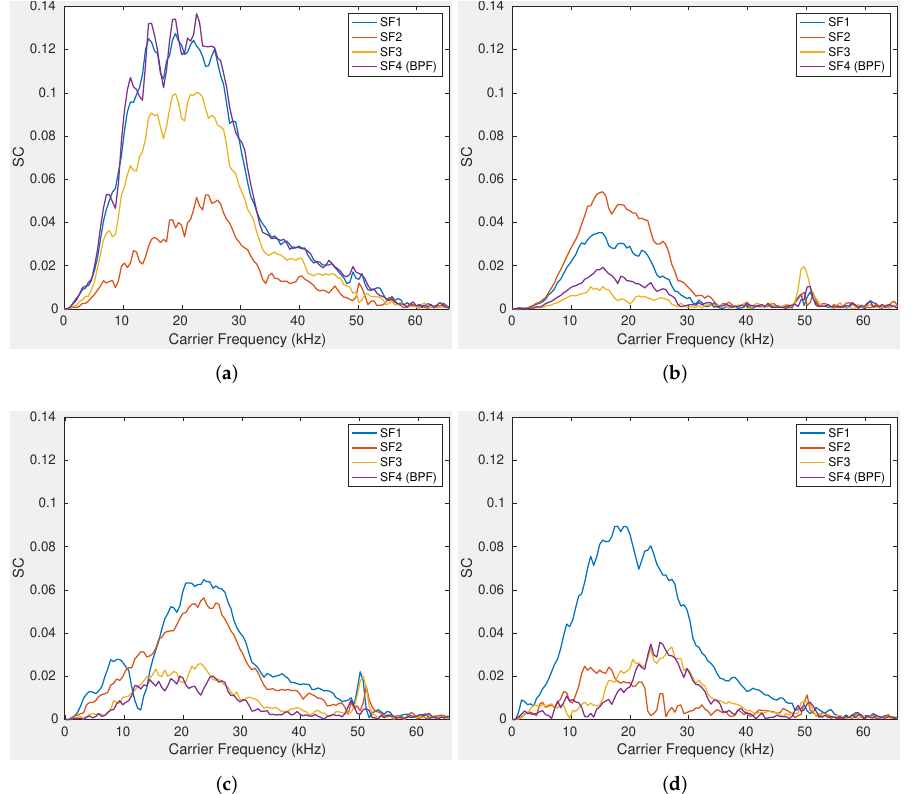
Figure 10. The spectral coherences (SC) γ ( α , f c ) of propeller cavitation noise across the entire carrier frequency f c range at the first four harmonics of shaft frequency, α = SF 1, SF 2, SF 3, SF 4, with propeller pitch ratios at ( a ) 82%, ( b ) 51%, ( c ) 40%, and ( d )